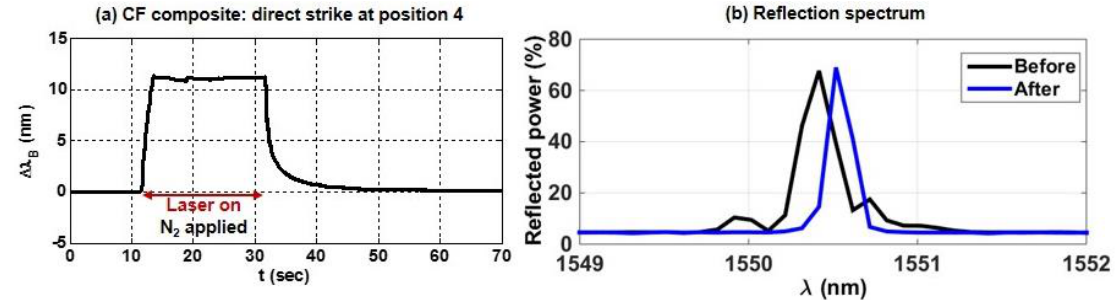
 and ( b ) the reflection spectrum (before and after) for a direct strike at Figure 8. The ( a ) shift Figure 8. The ( a ) shift ∆ λ B and ( b ) the reflection spectrum (before and after) for a direct strike at B position 4 in the CF position 4 in the CF composite.